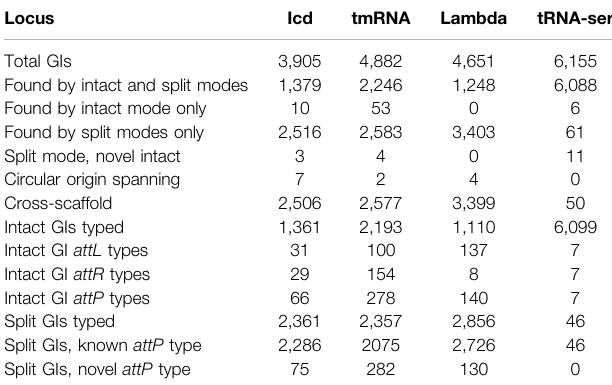
TABLE 1 | Validation of split GI calls at four commonly used integration loci. AnalysisofthetRNA-Ser locuswasfrom 6,283 Mycobacterium genomesand of the icd , tmRNA and lambda loci from 15,111 Escherichia